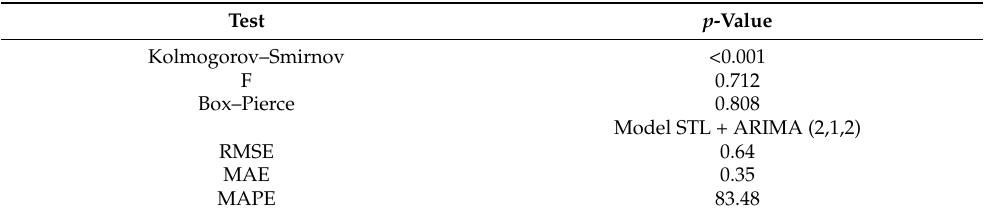
Table 1. Residuals and forecasting parameters of the STL + ARIMA model (2,1,2). Test p -Value